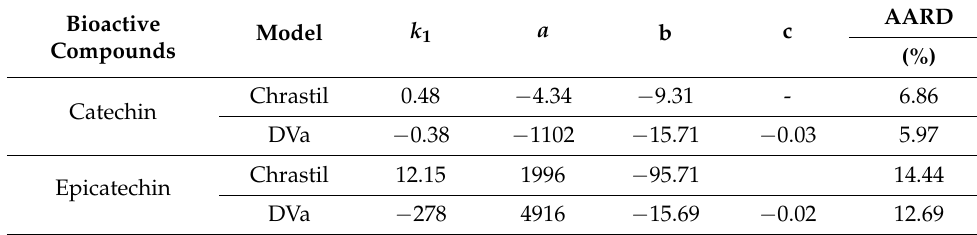
Table 6. Correlation data of the models fitted to the solubility of catechin and